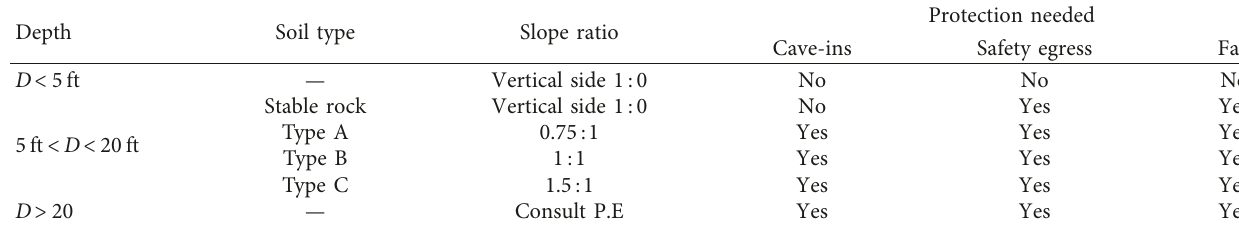
Table 2: OSHA regulations related to excavation